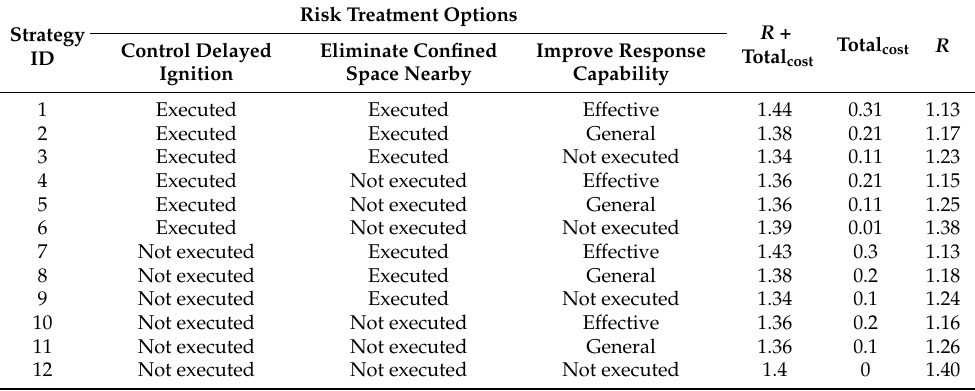
Table 5. Risk treatment options and their results.